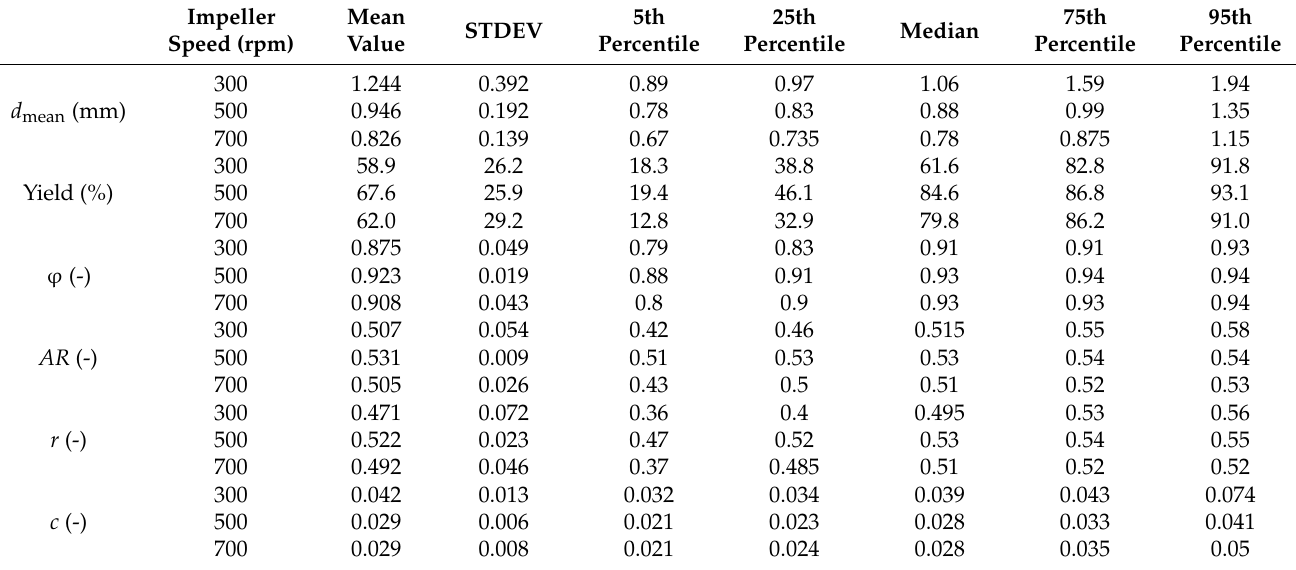
Table 2. Results of box charts analysis of individual investigated granulometric parameters and process